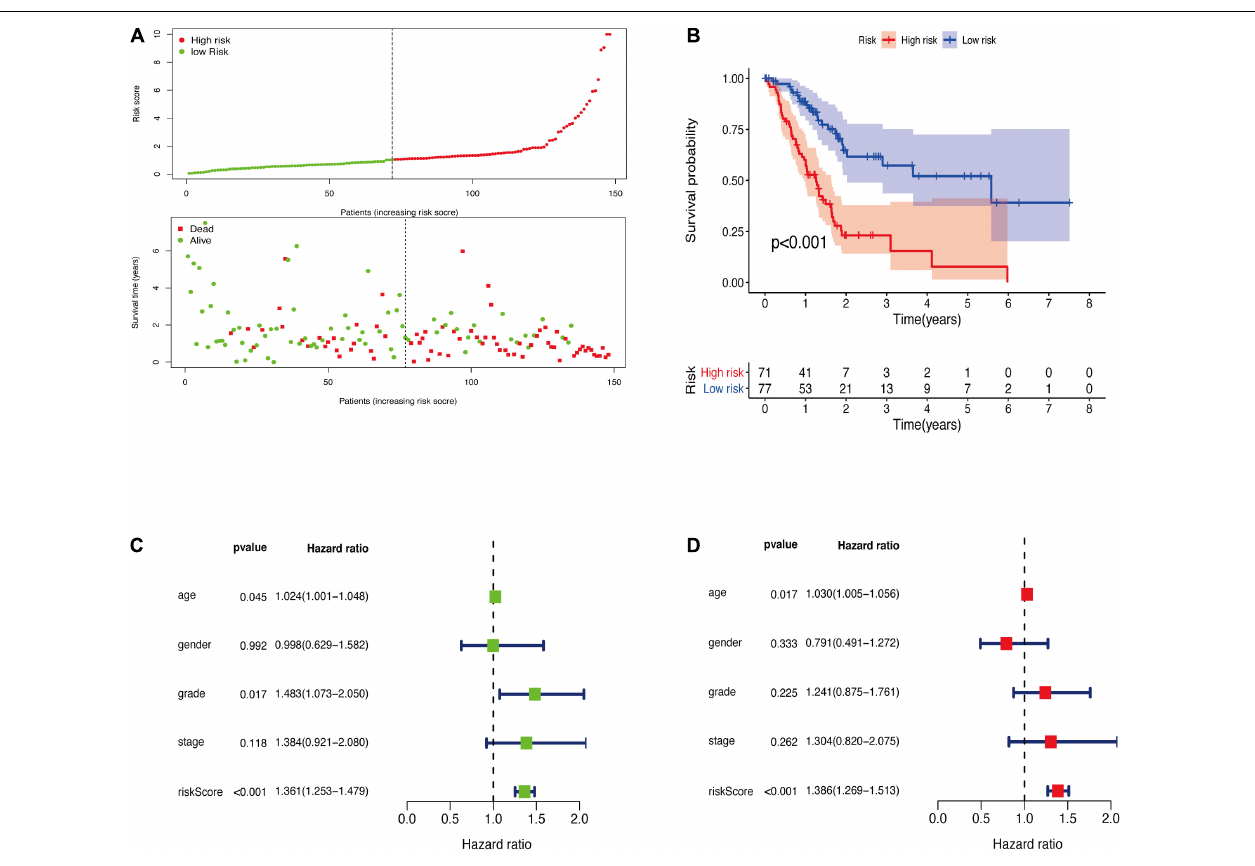
FIGURE 3 | (A) The model divides the training set patients into low-risk or high-risk groups. (B) Kaplan Meier curve between high and low risk groups. (C) Training set single factor Cox regression analysis forest map. (D) Training set multivariate Cox regression analysis forest